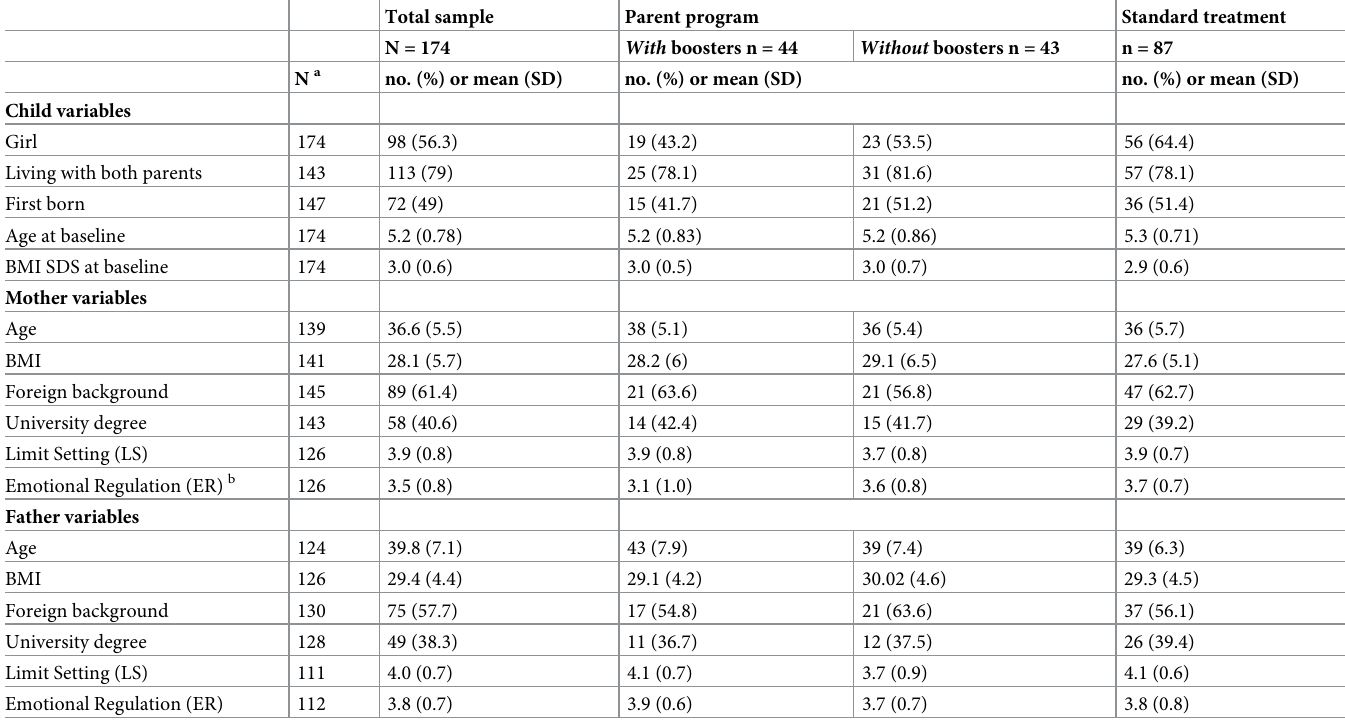
Table 4. Baseline characteristics and parental limit setting and emotional regulation in ML study. Total sample Parent program Standard treatment N = 174 With boosters n = 44 Without boosters n =